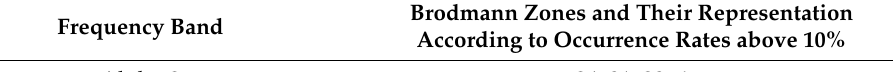
Table 2. Statistically significant Brodmann zones in status prior to stimulation (PRE CE) vs. stimu- lation (VOJTA CE).